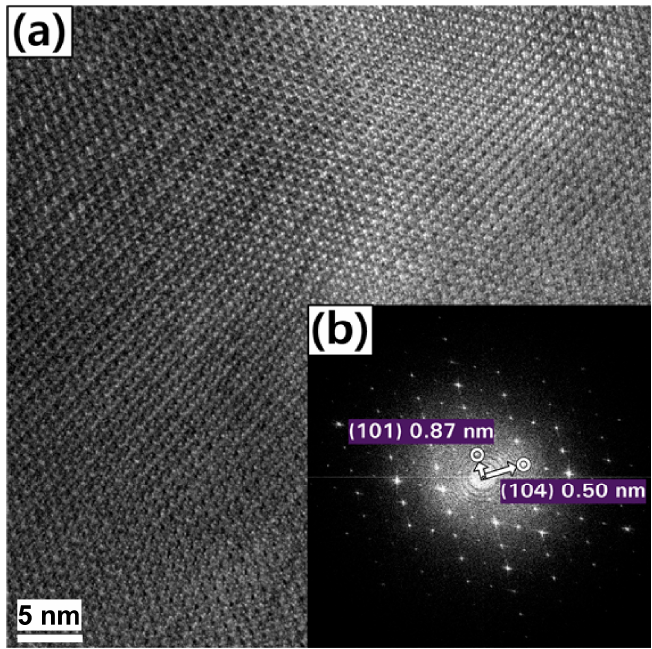
Figure 1. Transition electron microscopy (TEM) images of an un-milled boron particle: ( a ) The high-resolution TEM image, and ( b ) the corresponding fast Fourier transformation (FFT) pattern.